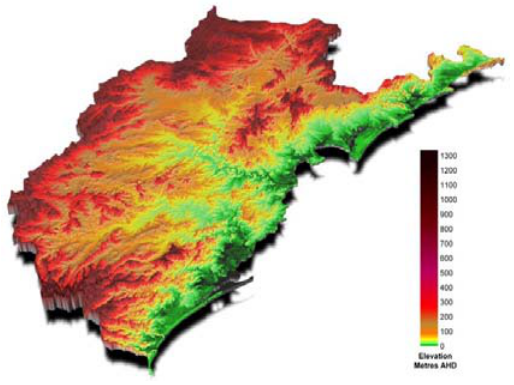
Figure 5. Data Development